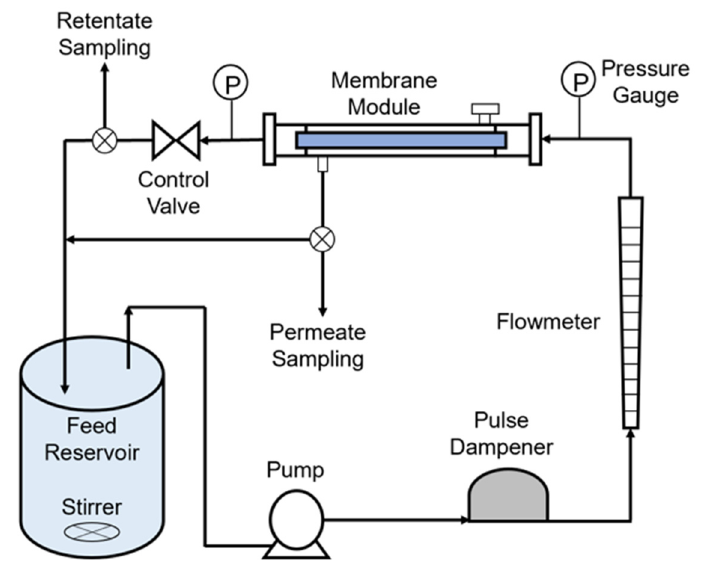
Figure 3. Schematic diagram of the membrane filtration system.